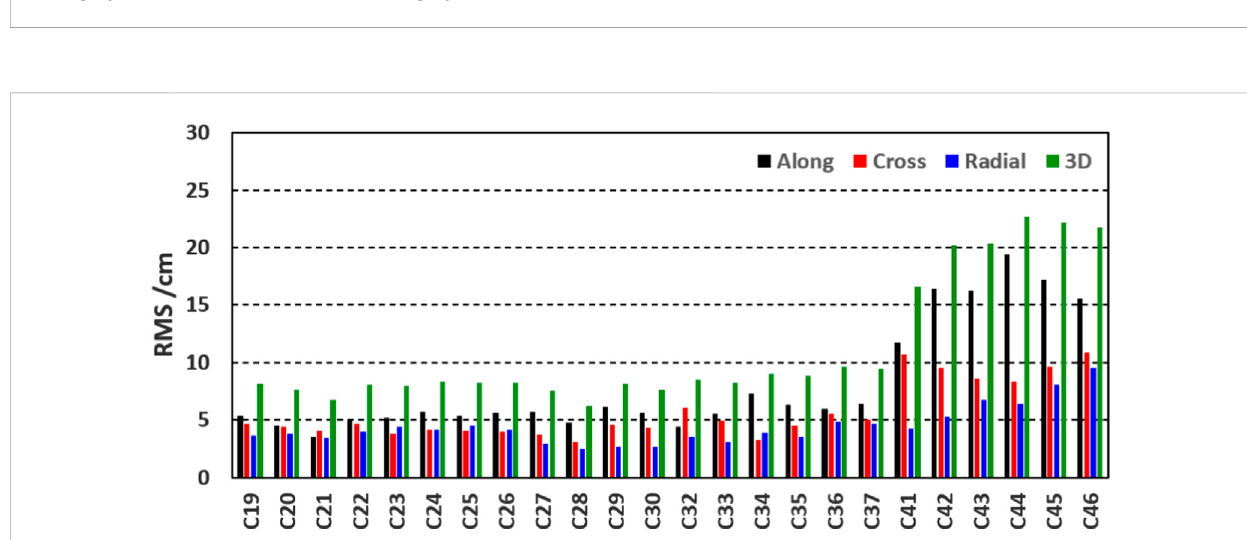
FIGURE 8 Average RMS of each BDS-3 MEO satellite orbit in along-track (the black bars), cross-track (the red bars), radial (the blue bars), and 3D (the green bars) compared to the wum